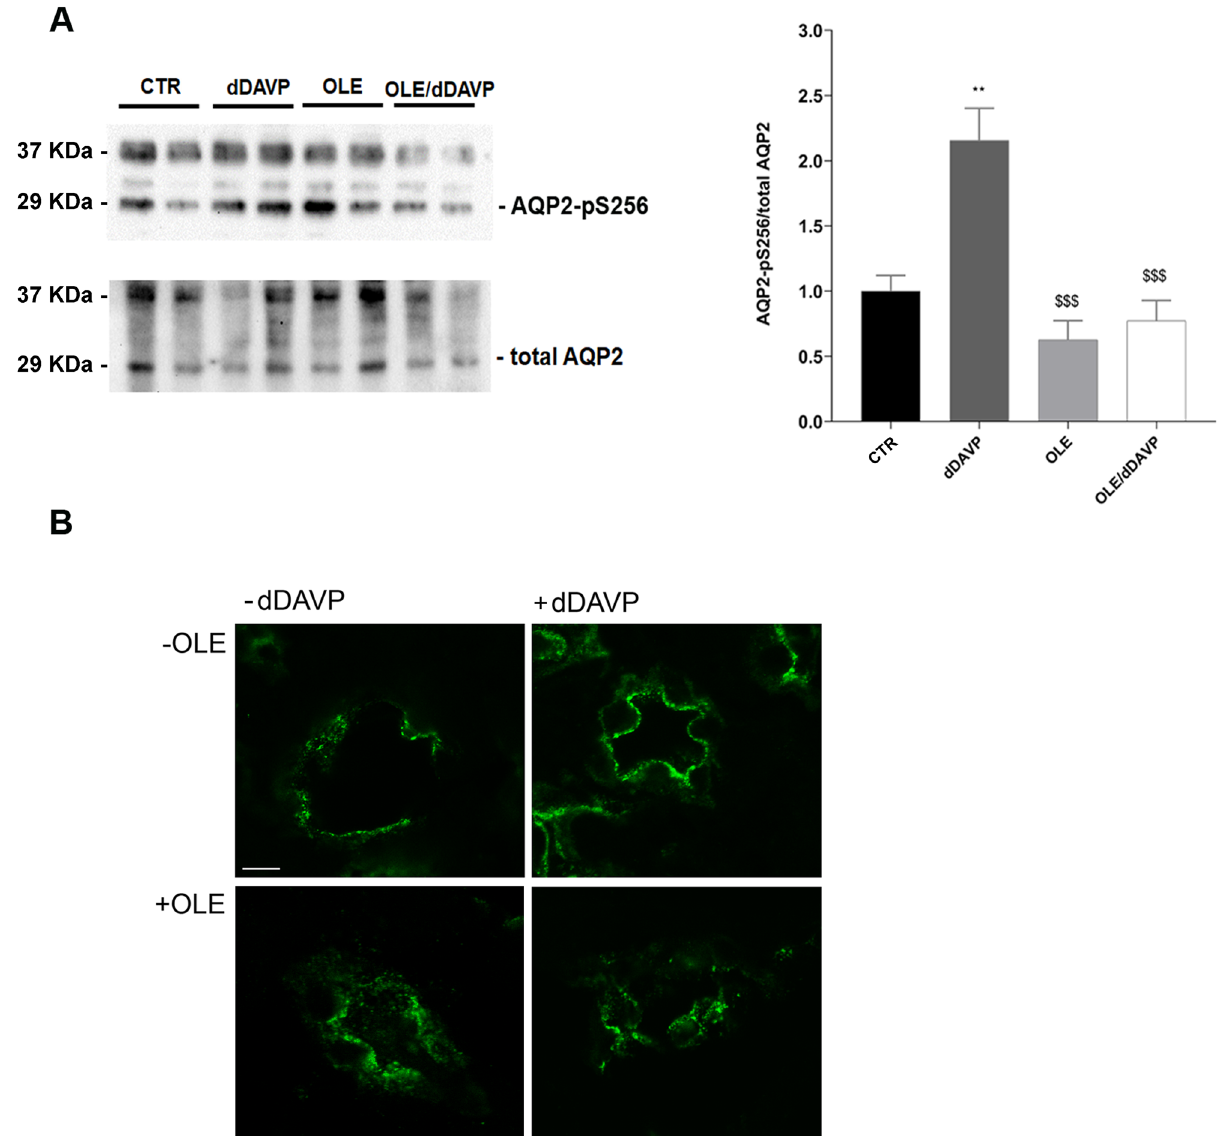
Figure 9. Effects of OLE on AQP2 phosphorylation and expression in rat kidneys. ( A ) Lysates from control and treated inner medulla kidney slices were subjected to immunoblotting using specific antibodies against AQP2-pS256 and total AQP2. Densitometric analysis of AQP2-pS256 bands normalized to total AQP2 bands (total AQP2) is reported in the histogram. Data are expressed as means ± S.E.M (**p < 0.01 vs CTR; $$$p < 0.001 vs dDAVP). ( B ) Rat kidney sections were stained for AQP2 and subjected to confocal laser scanning microscopy, as described in methods. Scale bar: 10